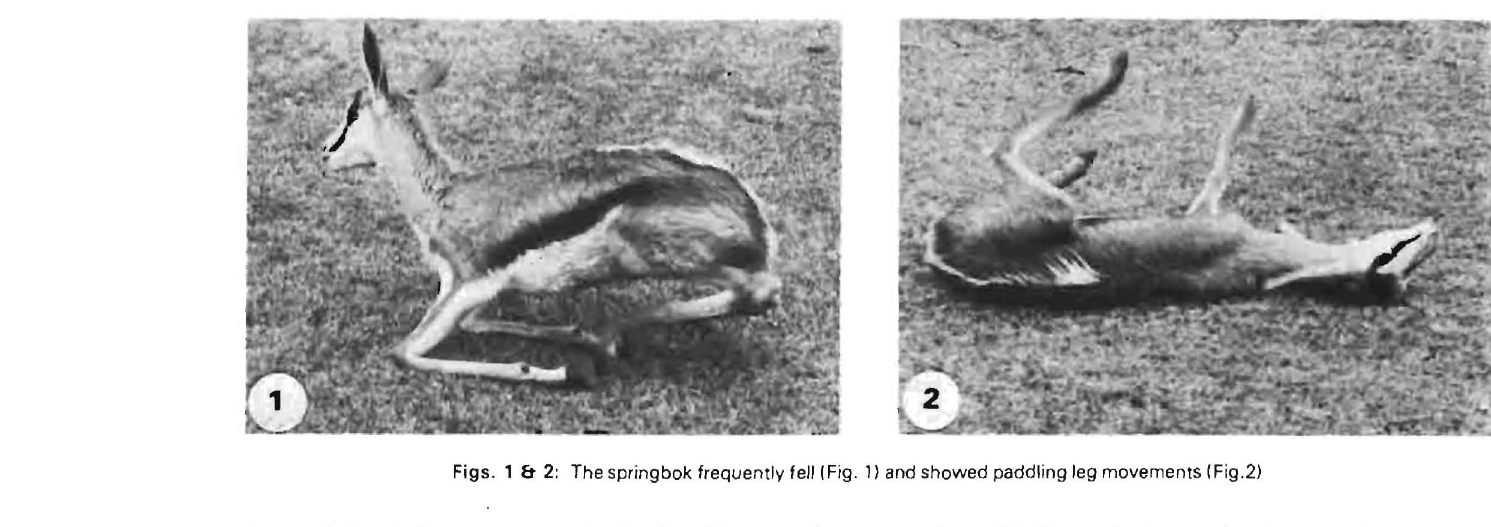
Figs. 1 & 2: The springbok frequently fell (Fig. 1) and showed paddling leg movements